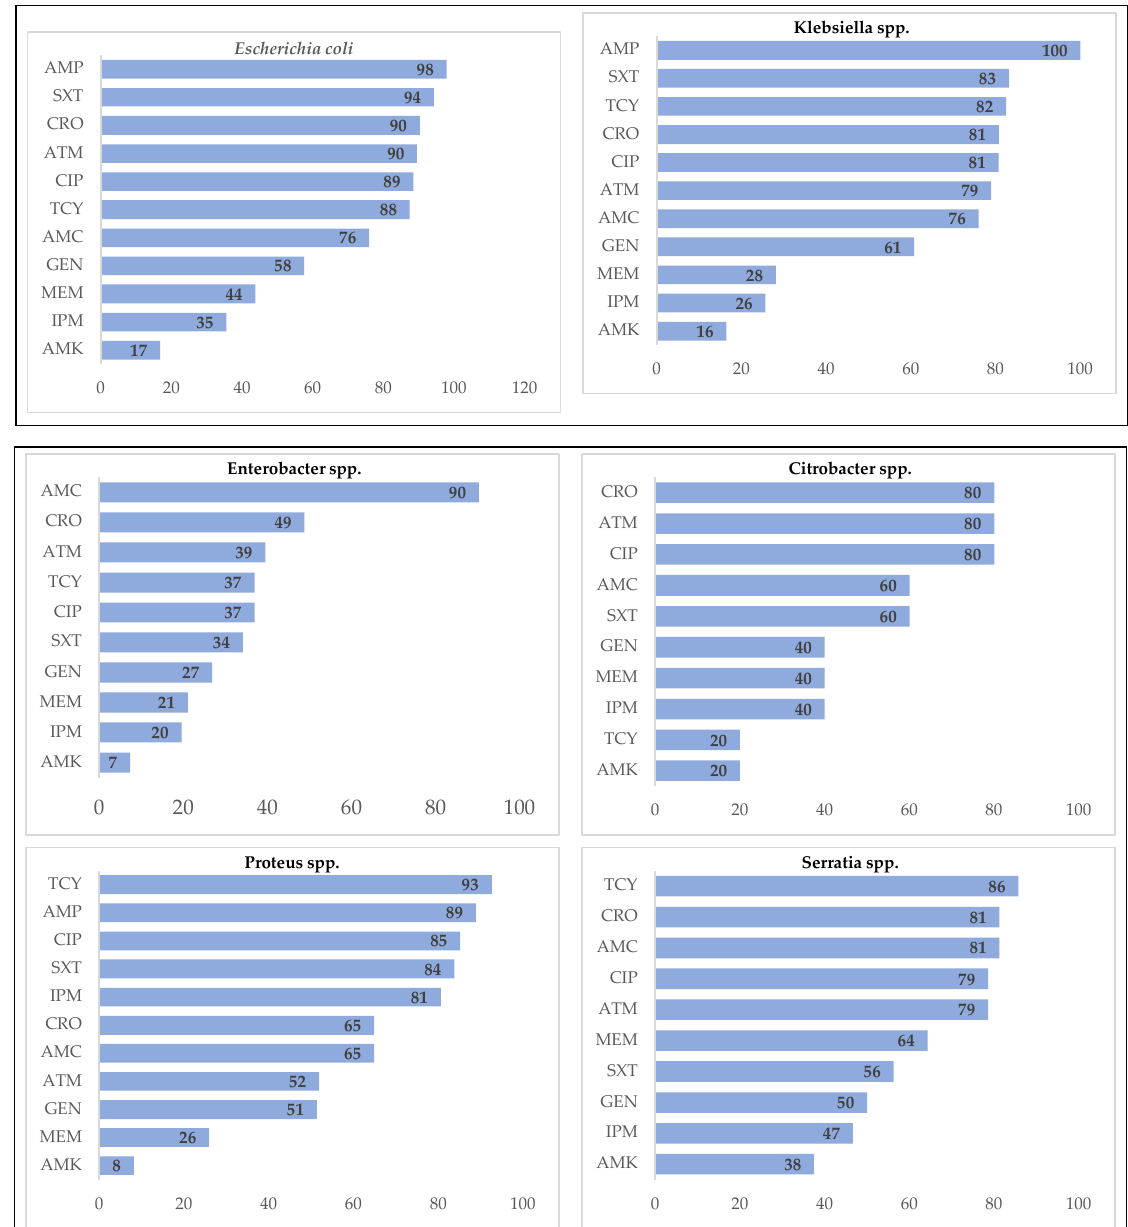
Figure 3. Antimicrobial resistance patterns in non-Enterobacteriaceae isolates at Yangon General Hospital, Myanmar, in 2018. X-axis represents the percentage of resistance. AMK = Amikacin, CIP = Ciprofloxacin, FEP = Cefepime, GEN = Gentamicin, IPM = Imipenem, LVX = Levofloxacin, MEM = Meropenem, SXT = Trimethoprim/Sulfamethoxazole, TZP = Piperacillin/Tazobactam.